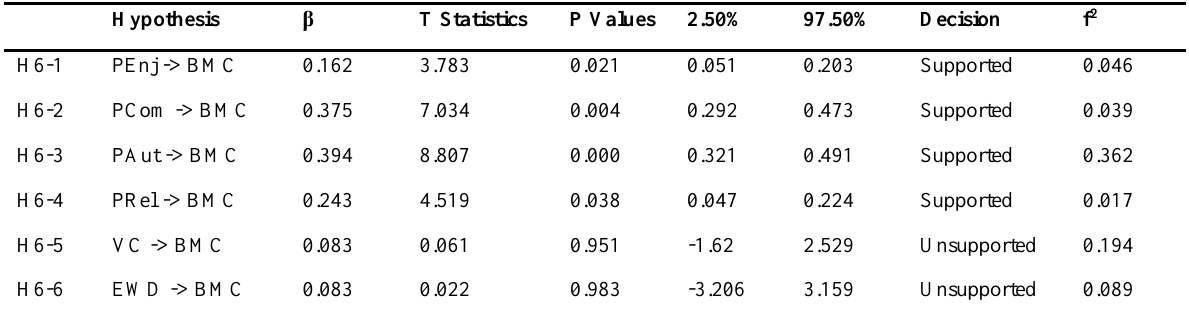
Table 4: PLS-SEM Path Analysis